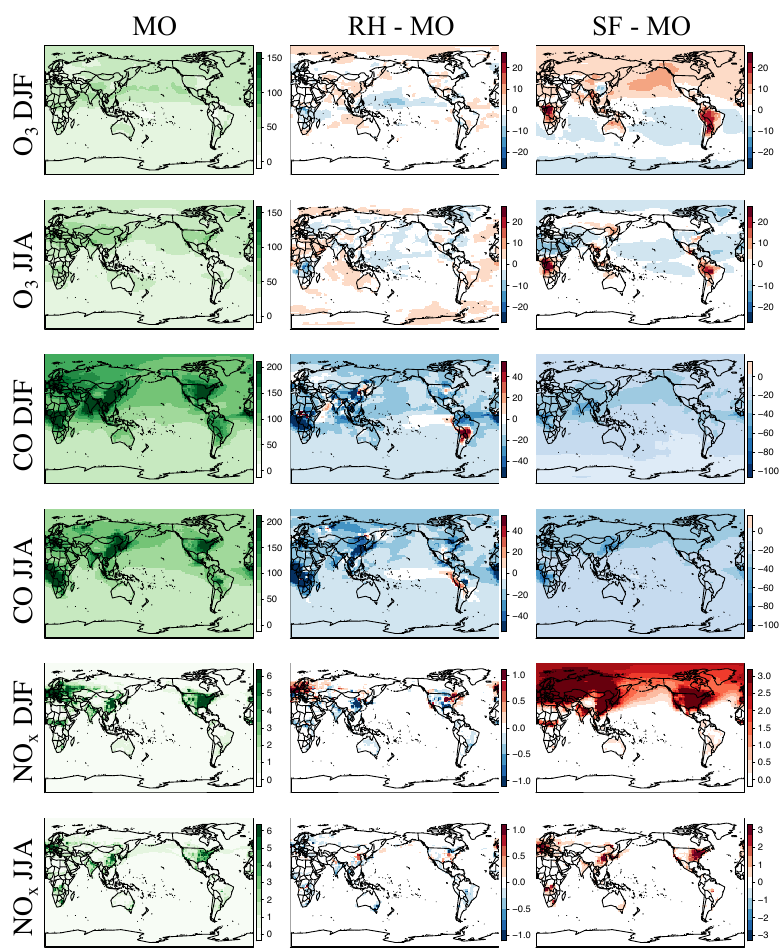
Figure 1. Maps of DJF and JJA O 3 , CO, and NO x for MO, the difference between RH and MO, and that between SF and MO for the year 2015. The chemical units are in ppb. Please note the difference in the chemical scales for each panel. Cool colors for the difference panels indicate MO is higher, and warm colors indicate that RH or SF is